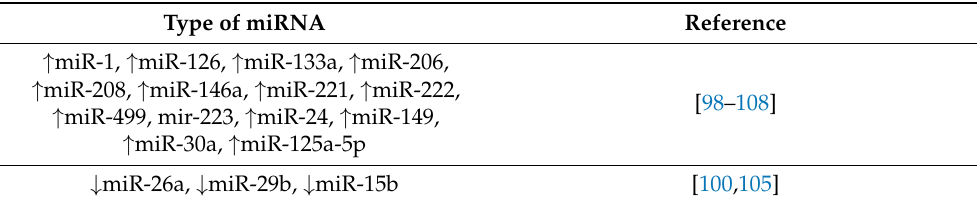
Table 1. miRNAs present in circulating blood and other body